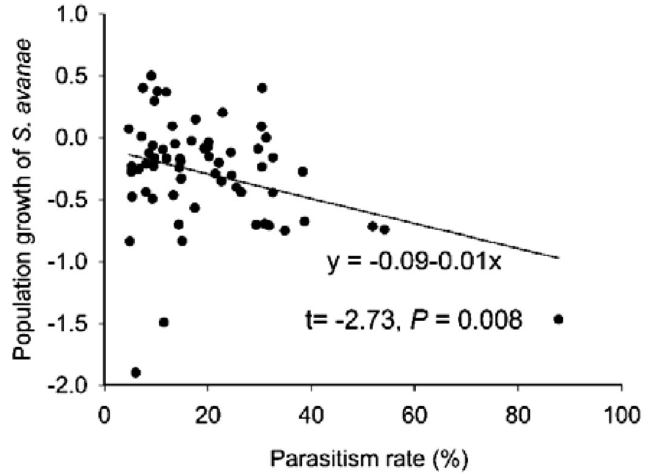
Figure 5. Relationship of population growth of S. avenae to parasitism rate in the milking phase during 2016– 2018. The population growth of S. avenae was calculated as the log 10 (x + 1) transformed density of S. avenae at the milking phase minus the log 10 (x + 1) transformed density of S. avenae at the flowering